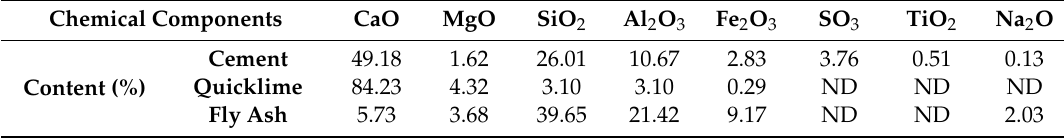
Table 4. Chemical composition of binders (expressed as oxides).